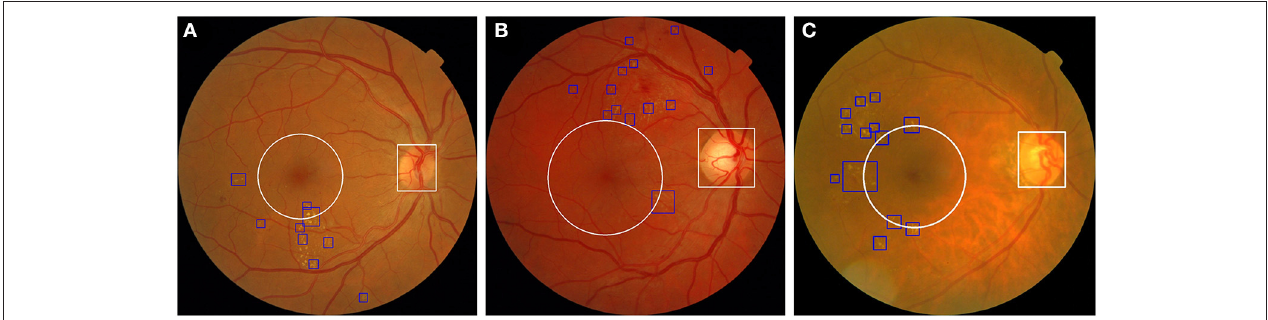
FIGURE 10 | Three fundus images from the open dataset were classified as DME in our system. (A) Fundus image from Messidor-1 dataset. (B,C) Two fundus images from the Messidor-2 dataset. Our system labeled HE lesions, optic disc, and 1DD from the macula center. The blue bounding box represents the HE. The white circle represents 1DD from the macula center. The white bounding box represents the optic